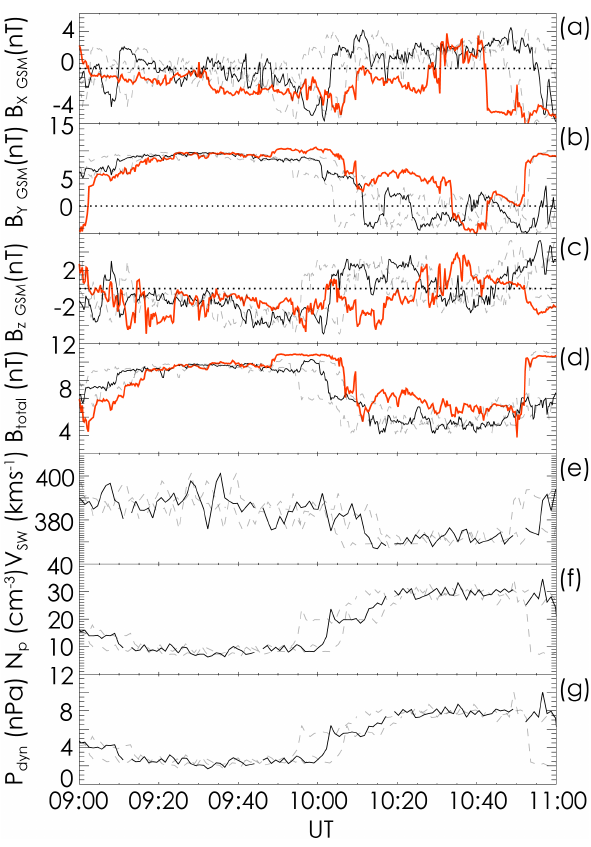
Fig. 2. ACE and IMP-8 spacecraft observations during the ULF wave event on 16 April 1998 between 09:00UT–11:00UT. Mag- netic field data are displayed in the GSM (Geocentric Solar Mag- netic) coordinate system. Panels (a) to (d) show the three magnetic field components recorded by the ACE and IMP-8 spacecraft, ( B x , B y , B z ) and the magnetic field magnitude, B total , respectively. Pan- els (e) , (f) and (g) show the solar wind velocity, the solar wind proton number density, and the solar wind dynamic pressure as recorded by ACE. The ACE data, with a 57min lag are shown by the solid black lines, whereas the IMP-8 data, lagged by 14min, are shown by the solid red lines. The dashed grey lines show a range of lag times (50–61min) for the IMF and solar wind data as observed by ACE (see text for